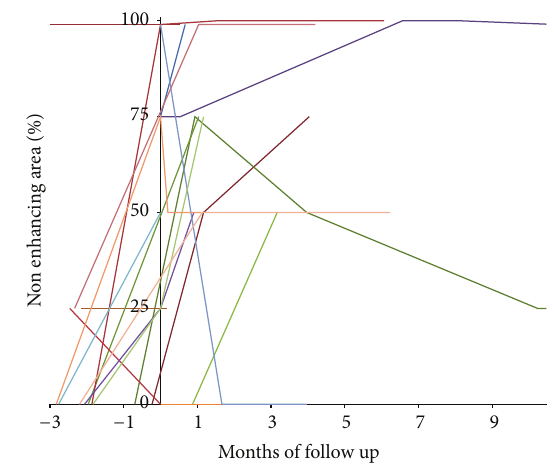
Figure 3: Nonenhancing areas within the hepatocellular carcinoma lesions over the follow-up period. Most of the lesions demonstrate increase in the nonenhancing area after treatment, mostly without significant change later on, unless a recurrence